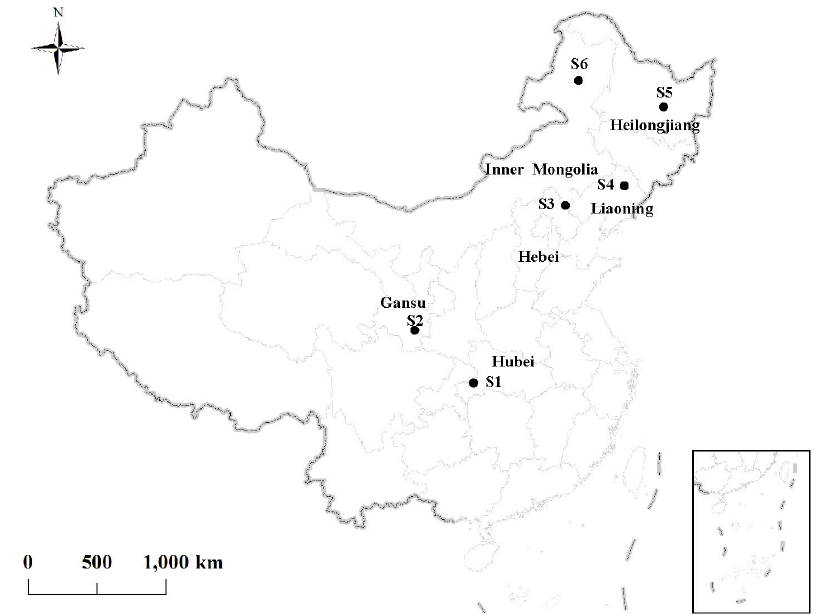
Figure 1. The regions where the stem wood, branch, needle, stem bark, root, and total biomass data were collected. Black dots represent specific locations for data collection, S1 in Hubei Province (30°48 ′ N, 110°02 ′ E), S2 in Gansu Province (34°09 ′ N, 105°52 ′ E). S3 in Hebei Province (41°43 ′ N, 118°7 ′ E). S4 in Liaoning Province (42°21 ′ N, 124°52 ′ E). S5 in Heilongjiang Province (46°32 ′ N, 129°10 ′ E). S6 in Inner Mongolia (49°34 ′ N, 121°25 ′ E).